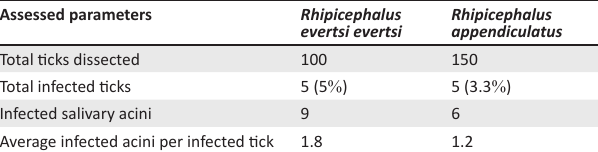
TABLE 2: Infection rate with Theileria in ticks recovered from carrier roan. Assessed parameters